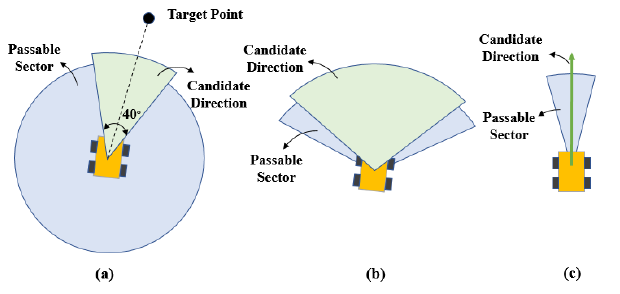
Figure 5. The candidate direction selection policy. ( a ) The selection when the passable sector is the whole circle. ( b ) The selection when the passable sector is large. ( c ) The selection when the detected passable sector is